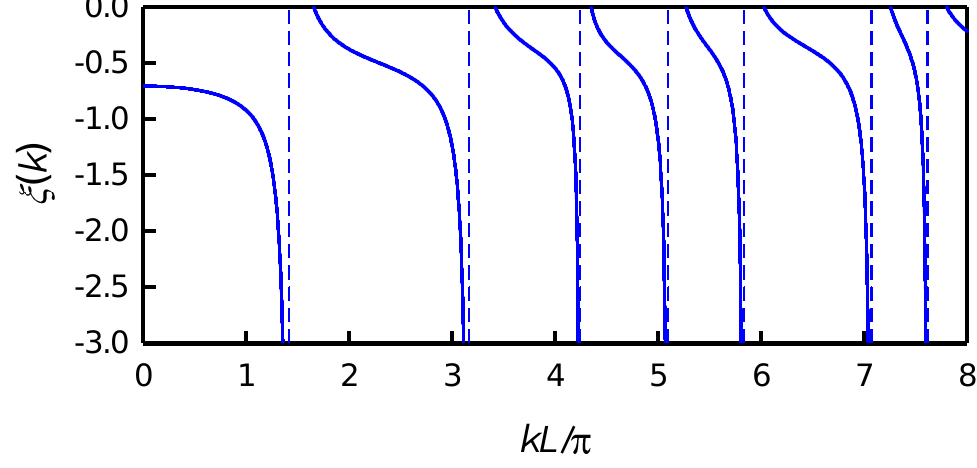
Figure 2. Calculated result for ξ ( k ) in Equation (8) as a function of k with r s = ( L /2, L /2 ) and N = 50. To demonstrate the trend of approach for computing eigenvalues with respect to − 1 the index N , the calculated results for [ 1 + α ξ ( k )] as a function of k for different N increasing from 10 to 50 are shown in Figure 3a for a given α = 5 and Figure 3b for a given α = 10. The eigenvalues k can be found to be located at the abrupt changes − 1 of the spectrum [ 1 + α ξ ( k )] . The convergence of the numerical eigenvalues can